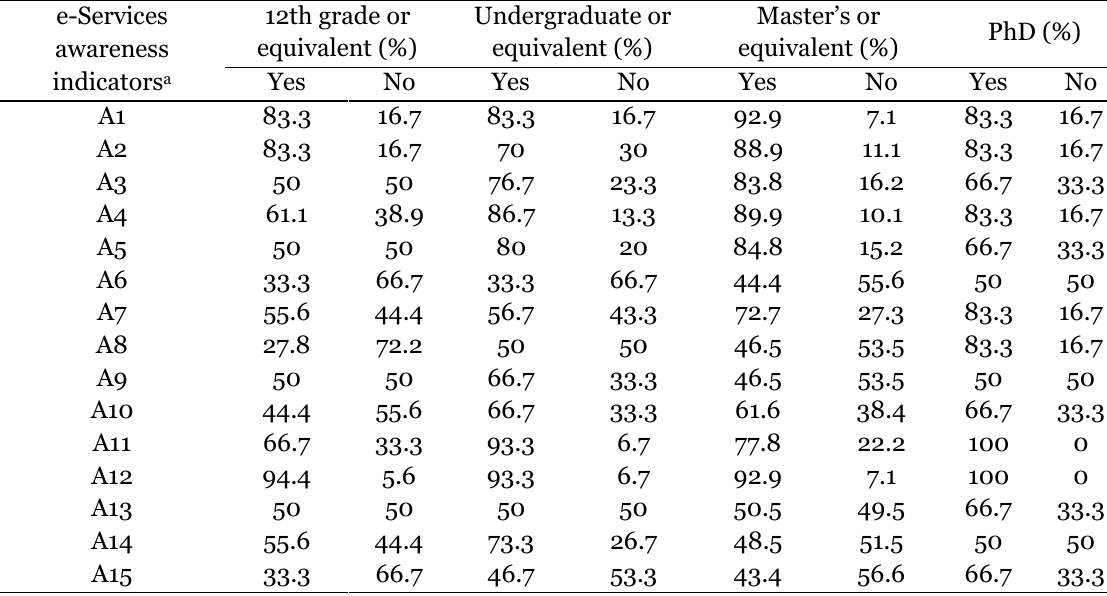
Learners’ Awareness of the University's e-Services by Education Level